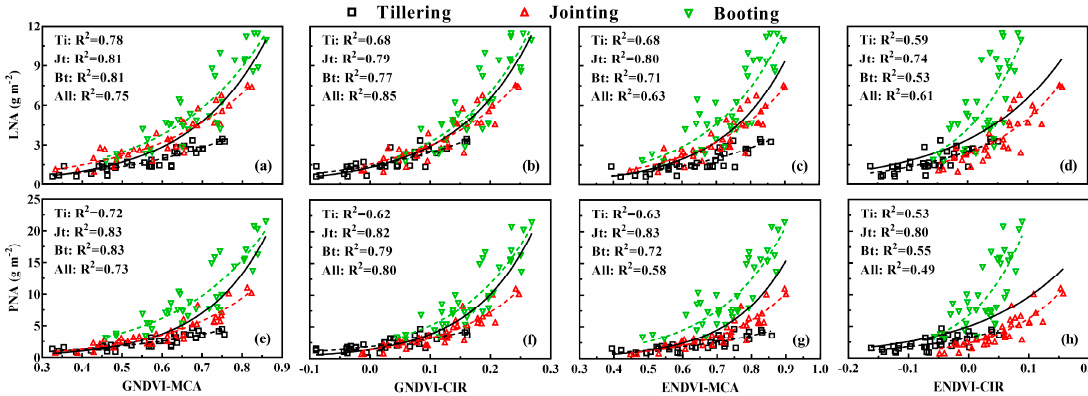
Figure 5. Leaf N accumulation (LNA, g m − 2 ) and plant N accumulation (PNA, g m − 2 ) plotted against vegetation indices from CIR and MS images: GNDVI-MCA ( a , e ), GNDVI-CIR ( b , f ), ENDVI-MCA ( c , g ) and ENDVI-CIR ( d , h ). The black solid line is for pooled data and the dashed lines are for individual stages. All regressions are statistically significant ( p < 0.01).